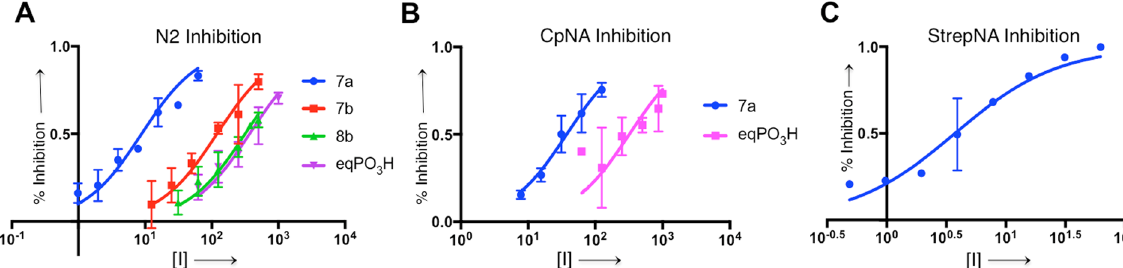
Figure 3. Sulfo-sialic acid analogue NA inhibition. Inhibition of N2 ( A ), CpNA ( B ) and StrepNA ( C ) hydrolysis of 4-methylumbelliferyl-Neu5Ac with 7a (blue), 7b (red), 8b (green) and eqPO 3 H (magenta). Error bars indicate standard error and inhibitor concentrations (x-axis) units are μ M.